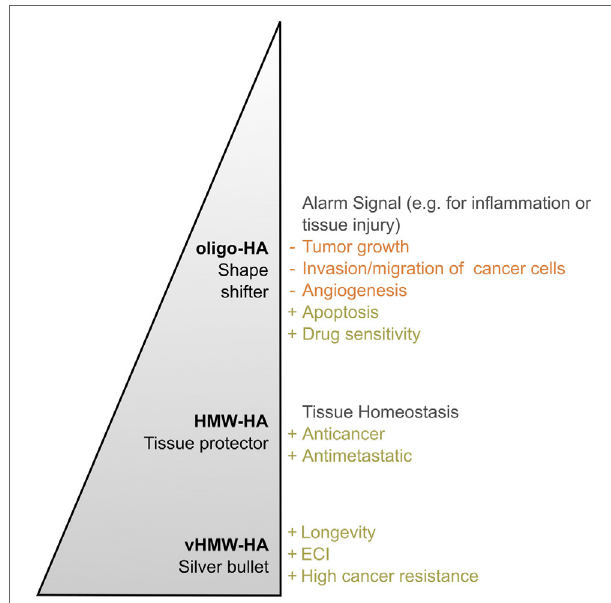
FiGURe 6 | Hyaluronan (HA)—a polymer with a multitude of roles. The effects of HA in both the healthy and diseased organism change with the molecular weight of the polymer in vivo . This becomes particularly obvious by comparing very high molecular weight HA (vHMW-HA) found in naked mole rats with the most important human molecular weight forms, namely high molecular weight HA (HMW-HA) and oligomeric HA (oligo-HA). Especially in the process of tumorigenesis, each molecular weight group can be described with its own characteristic role. While oligo-HA shows shape-shifting effects in cancer, HMW-HA mainly protects the human tissue. As reviewed above, various studies report this role distribution for HMW-HA and oligo-HA. Nevertheless, role reversal seems to be possible. vHMW-HA represents a silver bullet unique for naked mole rats as the high cancer resistance of the animal was attributed to this molecular weight form. The pyramid shape symbolizes the polymer length and, thus, molecular weight of each HA